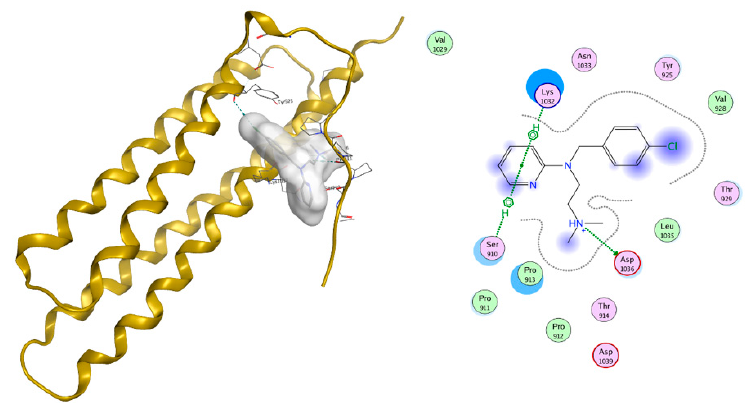
Figure 6. The predicted binding mode of chloropyramine (C4) showing detailed interactions with the pocket of the FAK-FAT domain; hydrogen bond is indicated by the dashed lines.